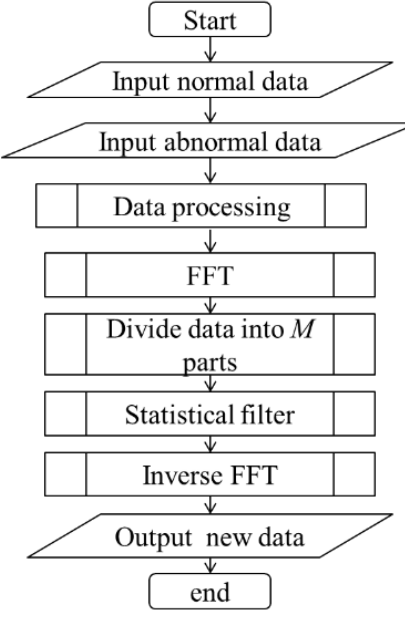
Figure 1. Process of the statistical filter.